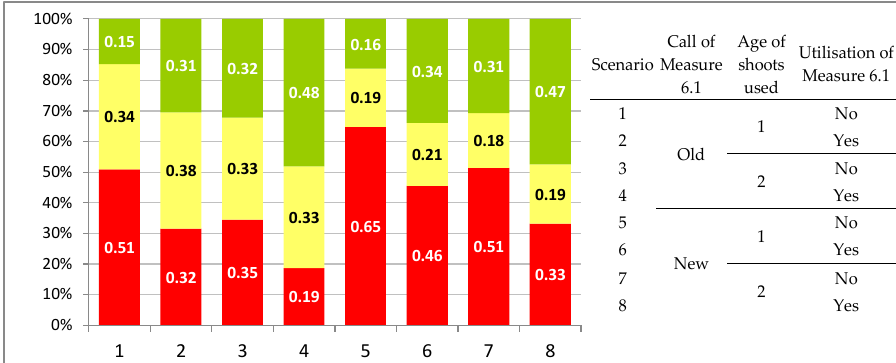
Figure 8. StopLight Chart for probabilities less than 0 (red light) and greater than 37,602 (green light) per scenario (source: own elaboration).